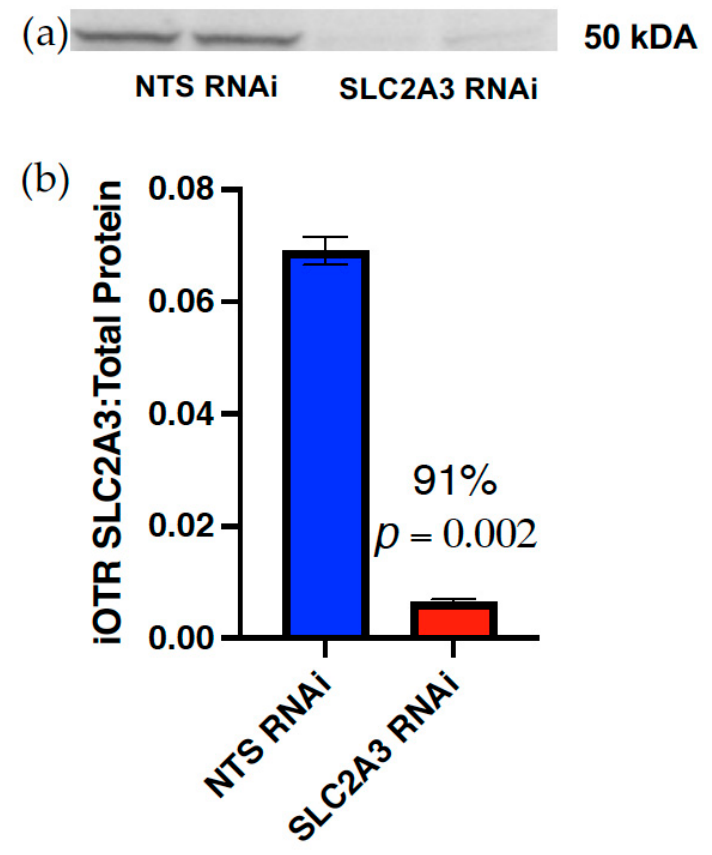
Figure 1. Efficiency of SLC2A3 RNAi in iOTR cells: ( a ) iOTR SLC2A3 detected by Western blot analysis following infection with either the NTS RNAi or SLC2A3 RNAi lentivirus; ( b ) concentration of SLC2A3, relative to total protein transferred, following infection with NTS RNAi or SLC2A3 RNAi lentivirus. Data are shown as means ± SEM. NTS, non-targeting sequence; RNAi, RNA interference. Table 1. Fetal and Doppler velocimetry measurements assessed at 70 dGA.